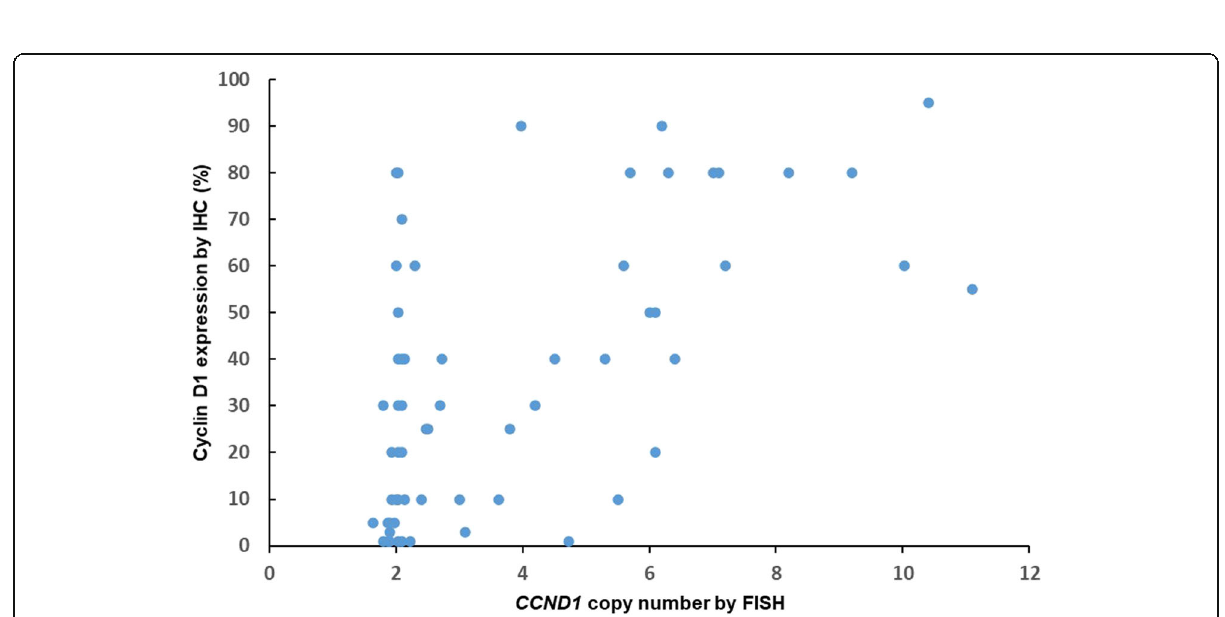
Fig. 5 The scatter plot shows the correlation of the CCND1 copy number by FISH and the cyclin D1 expression by